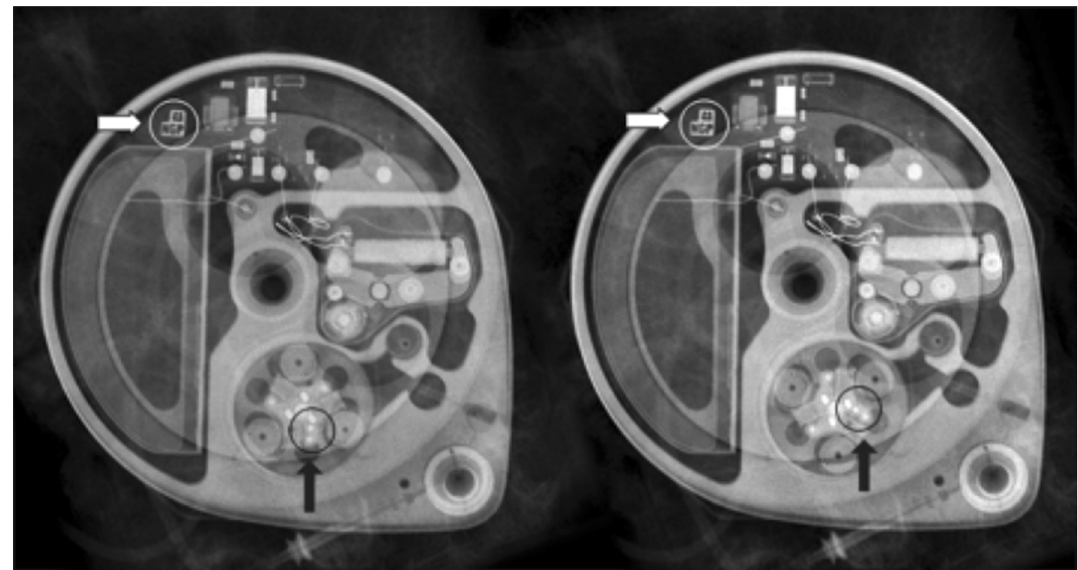
Fig. 12 In this pump rotor examination, a normal rotation was found (change in position indicated by the black arrows ). The white arrows show the pump position identifier (Fig.